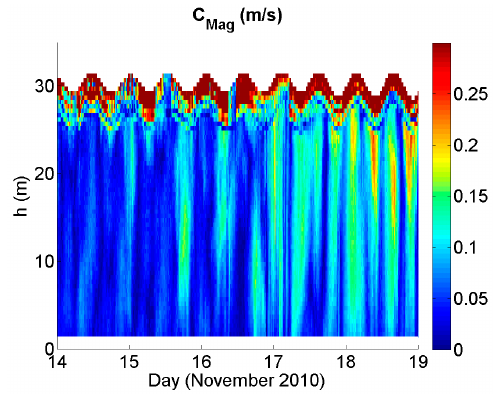
Figure 6. Example of current magnitude data recorded by the ADCP at SWMTF through the water column for several days.